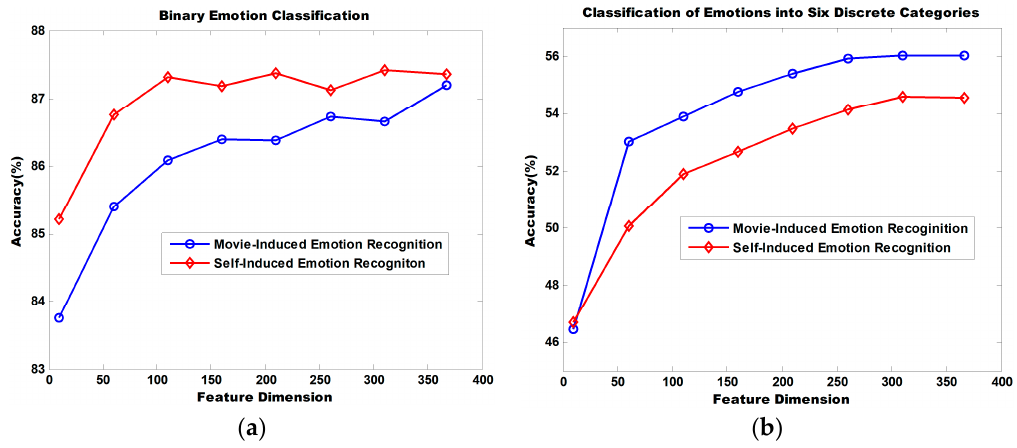
Figure 11. Dimensionality reduction using MRMR. MRMR is used to sort 366 features for each participant. The top 10, 60, 110, 160, 210, 260, and 310 features and all 366 features are utilized for emotion recognition. Average accuracy is computed for all participants. ( a ) Binary emotional classification with different numbers of features. ( b ) Classification of emotions into six discrete categories with different numbers of features.